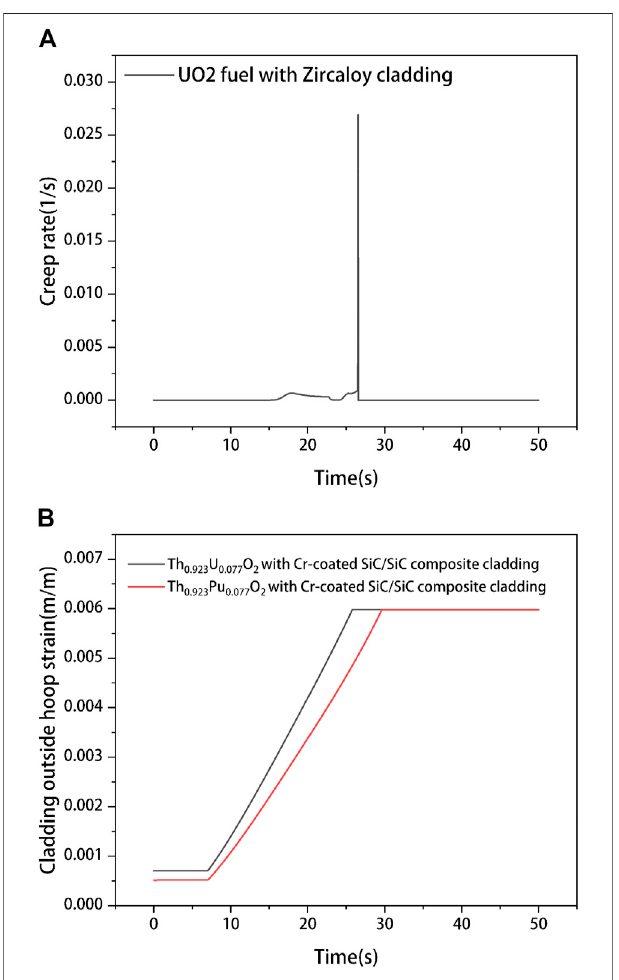
FIGURE16| Claddingfailuretimefor (A) UO 2 fuelwithZircaloycladding, (B) theTh 0.923 Pu 0.077 O 2 fuel,andTh 0.923 U 0.077 O 2 fuelwithCr-coatedSiC/SiC composite cladding under the LOCA condition.